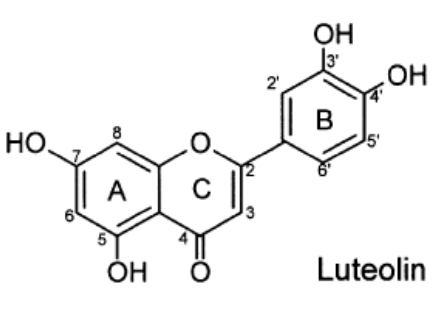
Figure 1. Chemical structure of